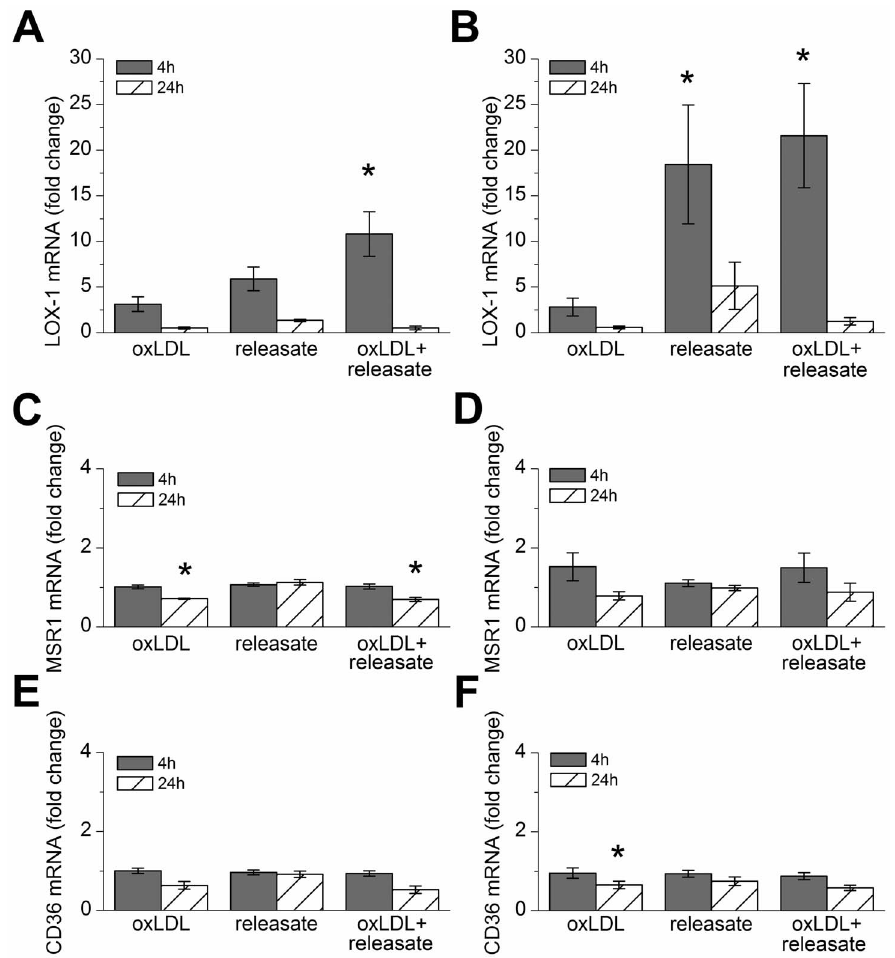
Figure 5.Time-dependent mast cell releasate-induced effects on oxLDL-stimulated macrophage scavenger receptor mRNA expression. Monocyte-derived macrophages were incubated with 50 m g/ml of DiI-oxLDL and/or in LAD2 (A, C, E) or primary mast cell (B, D, F) releasate for 4 h and 24 h, and analyzed for LOX-1, MSR1 and CD36 mRNA expression. The results are presented as means 6 SEM (n=4 donors). *p , 0.05; **p , 0.01.